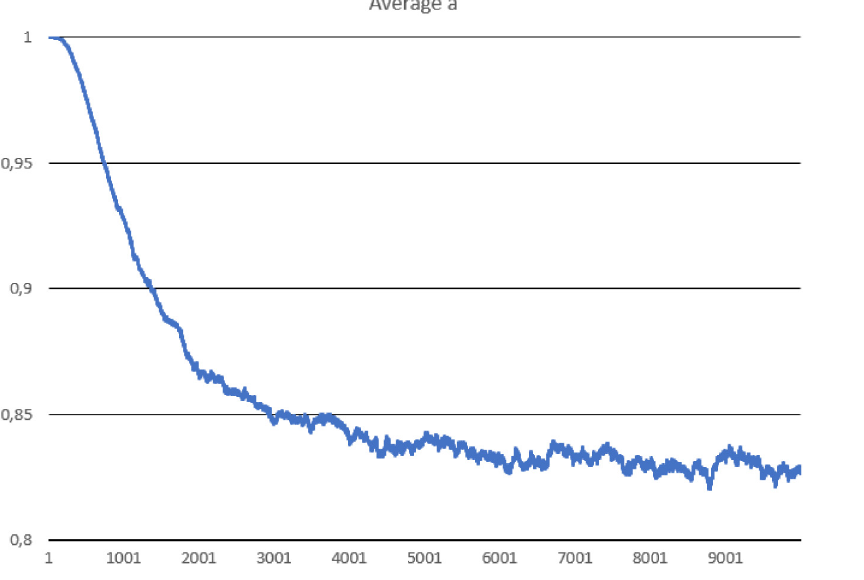
Fig 3. The average replication efficiency of replicases in Scenario